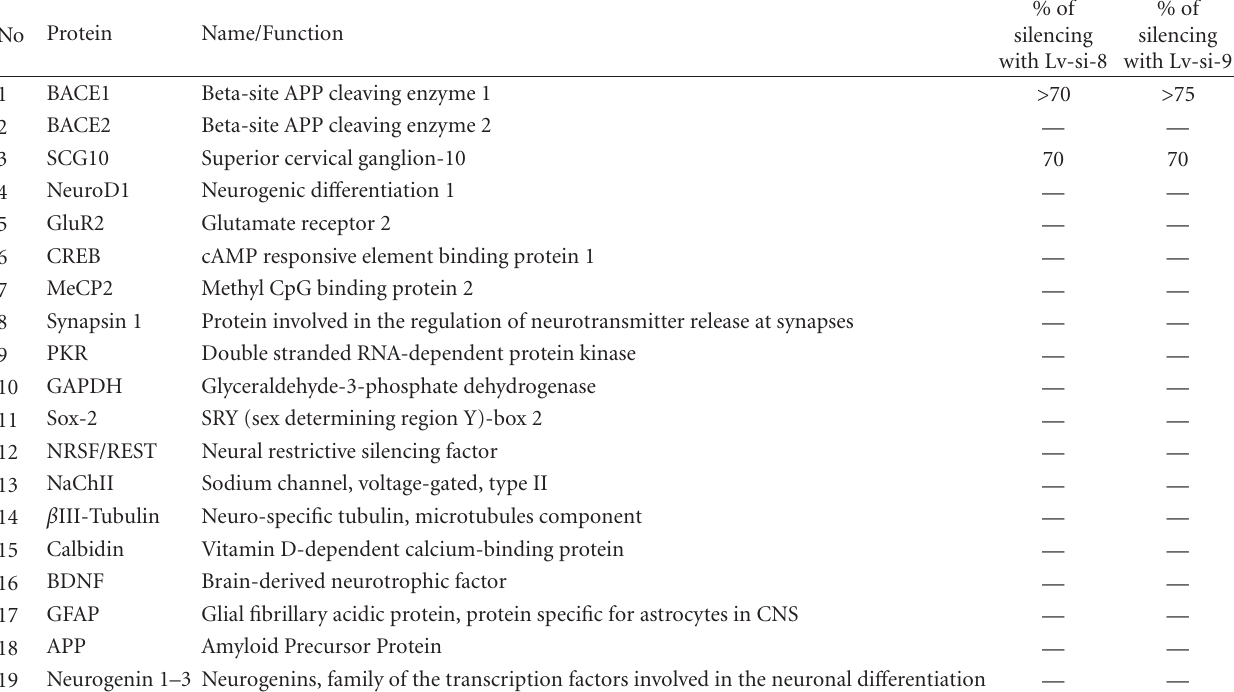
Table 2: List of genes selected for expression level evaluation in HCN A94 cells transfected with BACE1-specific si-5b and si-6, coded in lentivirus vector.